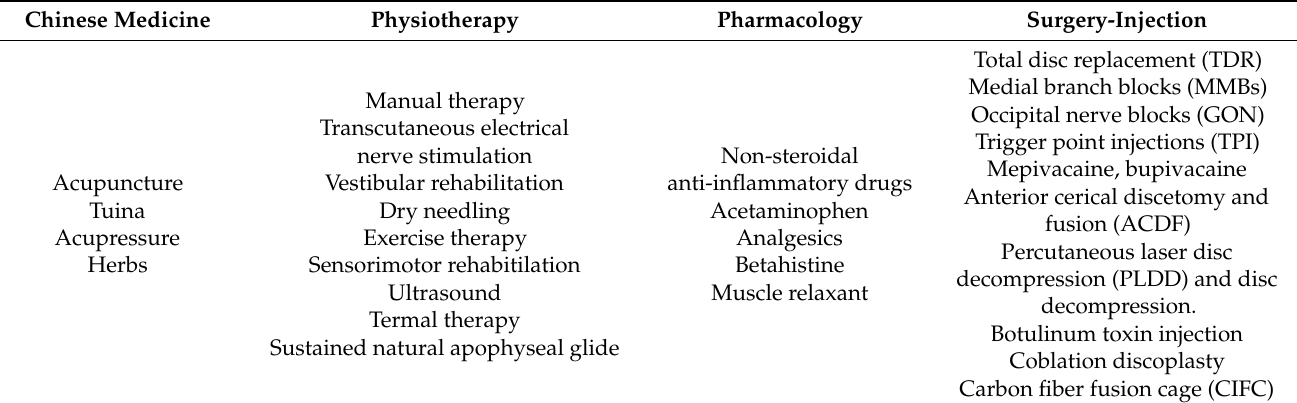
Table 3. Intervention modalities in Proprioceptive cervicogenic dizziness